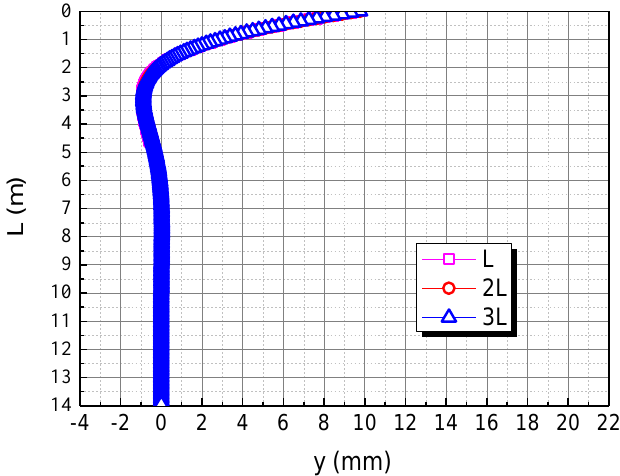
Figure 6. Effect of pile length on horizontal displacement of pile body in calcareous sand area.